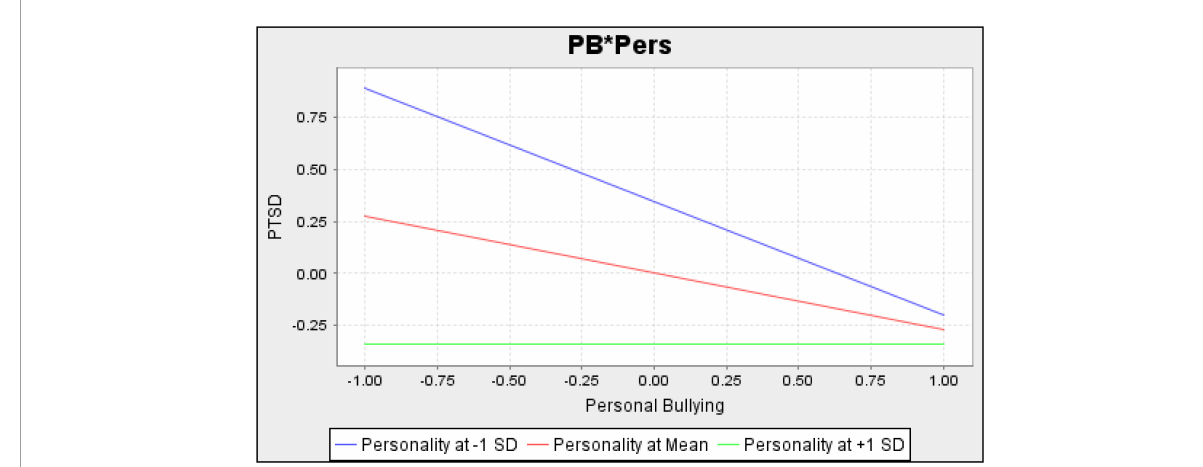
FIGURE4 Personality as a moderator between personal bullying and post traumatic stress disorder.